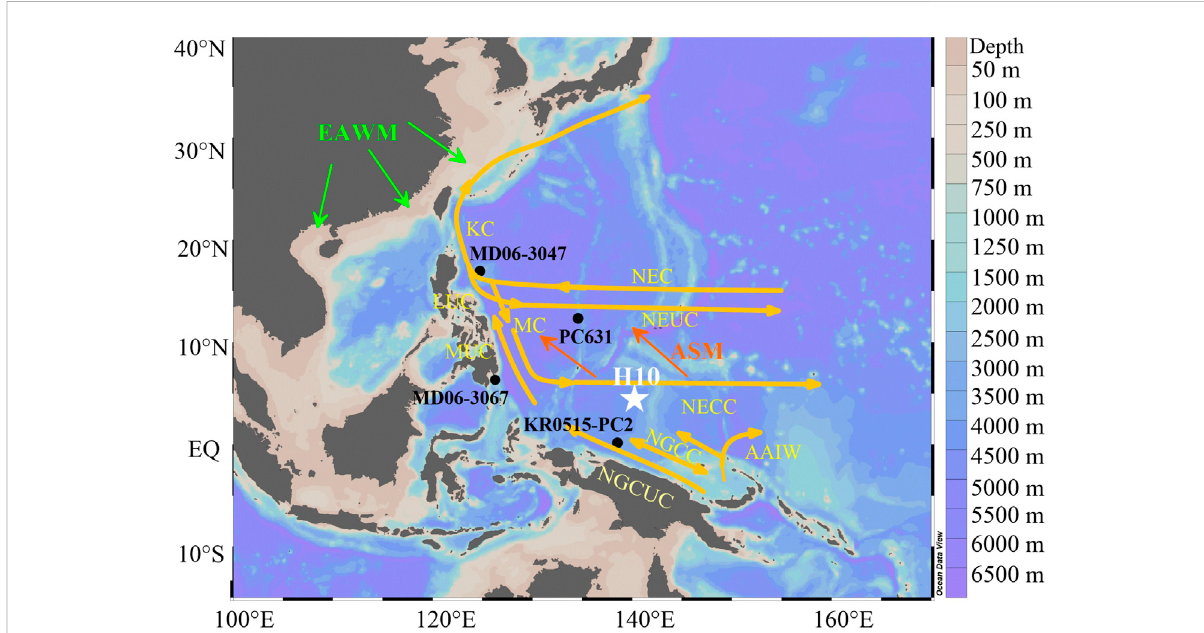
FIGURE 1 GeographicallocationsofcoreH10(whitepentagram).Blackdotsdenotereferencecores,includingcoresMD06-3047(Xuetal.,2012),MD06- 3067 (Kissel et al., 2010), PC631 (Seo et al., 2014), and KR0515-PC2 (Yamazaki and Horiuchi, 2016). The seabed topographic distribution was plotted using Ocean Data View software (Schlitzer, 2022). Orange arrows indicate the main oceanic currents acting in the WPWP region. AAIW, Antarctic Intermediate Water; KC, Kuroshio Current; LUC, Luzon Undercurrent; MC, Mindanao Current; MUC, Mindanao Undercurrent; NEC, North Equatorial Current; NECC, North Equatorial Counter Current; NEUC, North Equatorial Undercurrent; NGCC, New Guinea Coastal Current; NGCUC, New Guinea Coastal Undercurrent; EAWM, East Asian winter monsoon; ASM, Asian summer